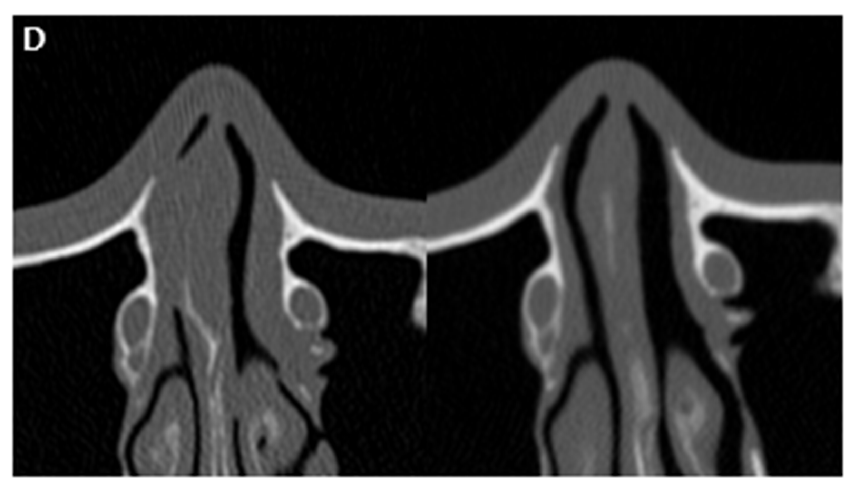
Figure 4. Representative endoscopic examination and CT imaging. ( A ) A preoperative endoscopic examination. ( B ) The postoperative endoscopic examination shows symmetric changes in bilateral nasal cavities. ( C , D ) Preoperative and postoperative CT images show corrected the PPE and upper part of cartilaginous septum after surgery.